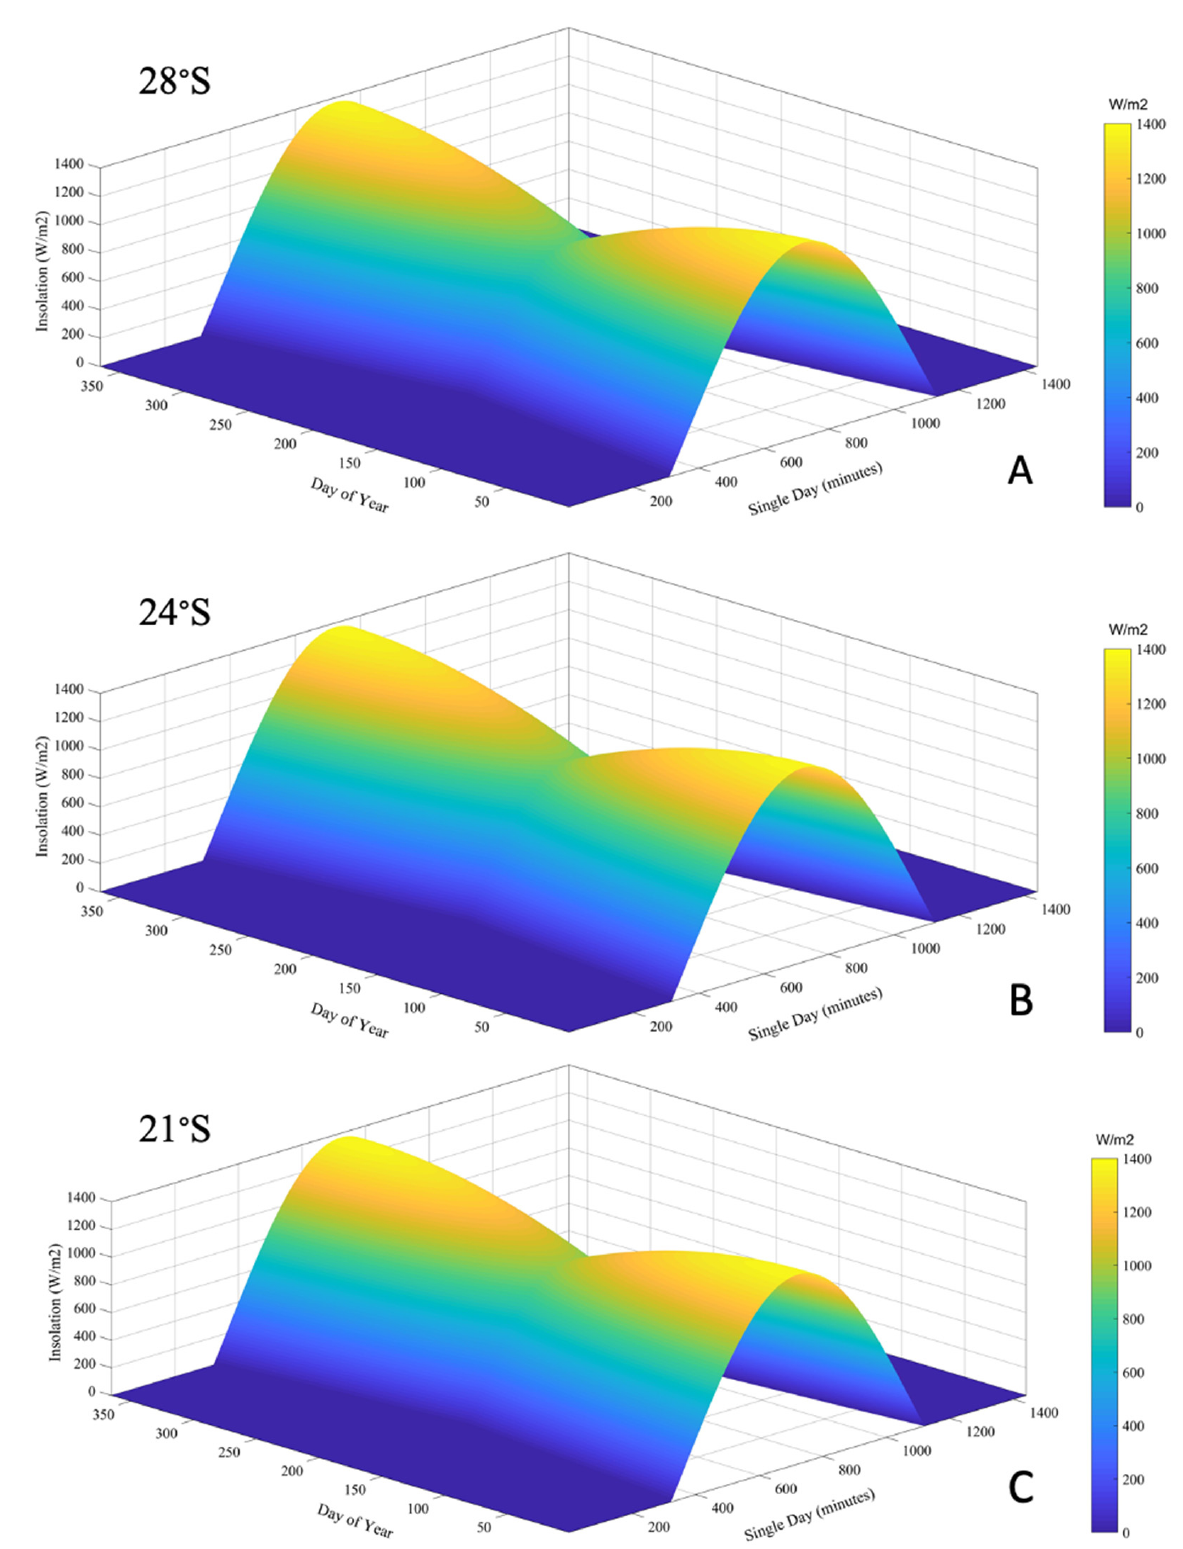
Figure 8. Incoming solar radiation (W/m 2 ) throughout the year and the days (Julians) in three locations in Brazil. ( A ) Lages, Santa Catarina state (latitude 28 ◦ S); ( B ) Palotina, Parana state (24 ◦ S); ( C ) Ribeirao Preto, Sao Paulo state (21 ◦